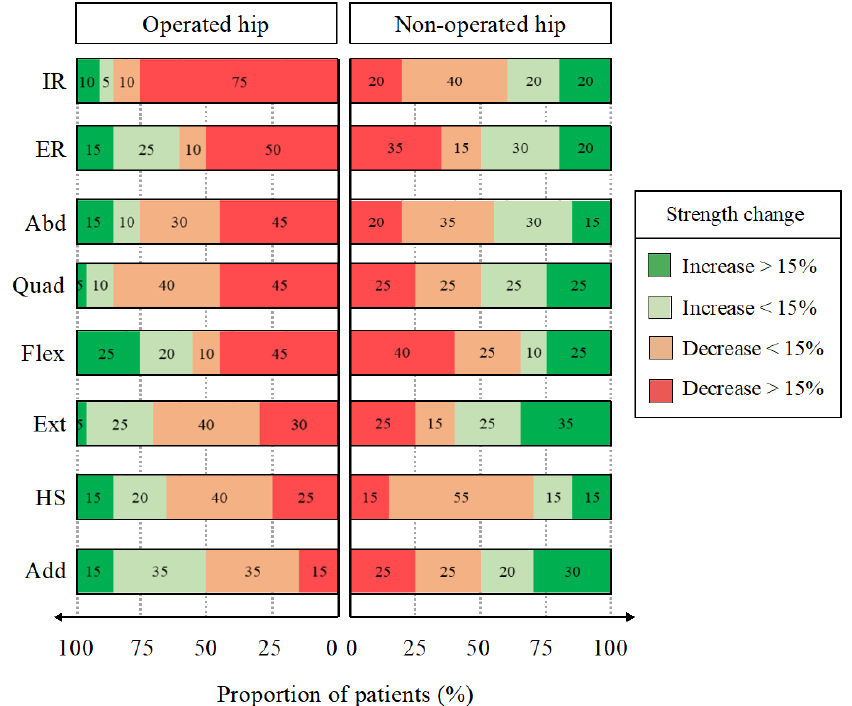
Figure 6. Patients distribution according to the relevance of their muscle strength change following SHD on the operated and non-operated hip. Dark green and red indicate clinically relevant variations. Internal rotators (IR), external rotators (ER), quadriceps (Quad), abductors (Abd), extensor (Ext), hamstrings (HS), flexors (Fl), adductors (Add). The changes in external rotator strength were strongly correlated with those exhib- ited by the extensors (r = 0.74, p < 0.001) and abductors (r = 0.71, p < 0.001), and the changes in extensors strength were moderately correlated with those exhibited by the abductors (r = 0.67, p < 0.001). 4. Discussion The decision-making in the surgical treatment of FAI patients rarely relies on surgeon preferences solely. Even though arthroscopy is often considered as the gold standard treatment for FAI [7 – 9], SHD can be an adequate surgical option for patients with signifi- cant bone deformities or concomitant pathologies [10,11]. Since the aforementioned sur- geries are performed on patients with different characteristics, the aim of the study was to report the strength changes in hip muscles for each procedure separately. 4.1. Arthroscopy Our main results revealed a significant decrease in the strength of the abductors, ex- ternal rotators, hip flexors and hamstrings on the side of the operated limb. The surgery lightly affected the hamstrings (by 5%), flexors (by 6%) and external rotators (by 7%) on the operated side. The abductors strength was the only muscle that was at least moder- ately affected (by 11%), with almost half of the patients having an important and relevant decrease in strength (>15%). Muscle strength reduction on the operated side and postoperative side-to-side mus- cle imbalance should not be the only warning signals. Surprisingly, we observed that both operated and non-operated hips exhibited a decrease in external rotators strength